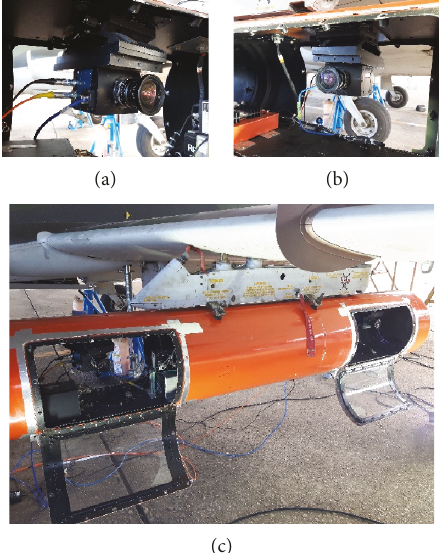
Figure 2: Cameras installed and positioned: (a) front camera, (b) rear camera, and (c) photographic pod with 2